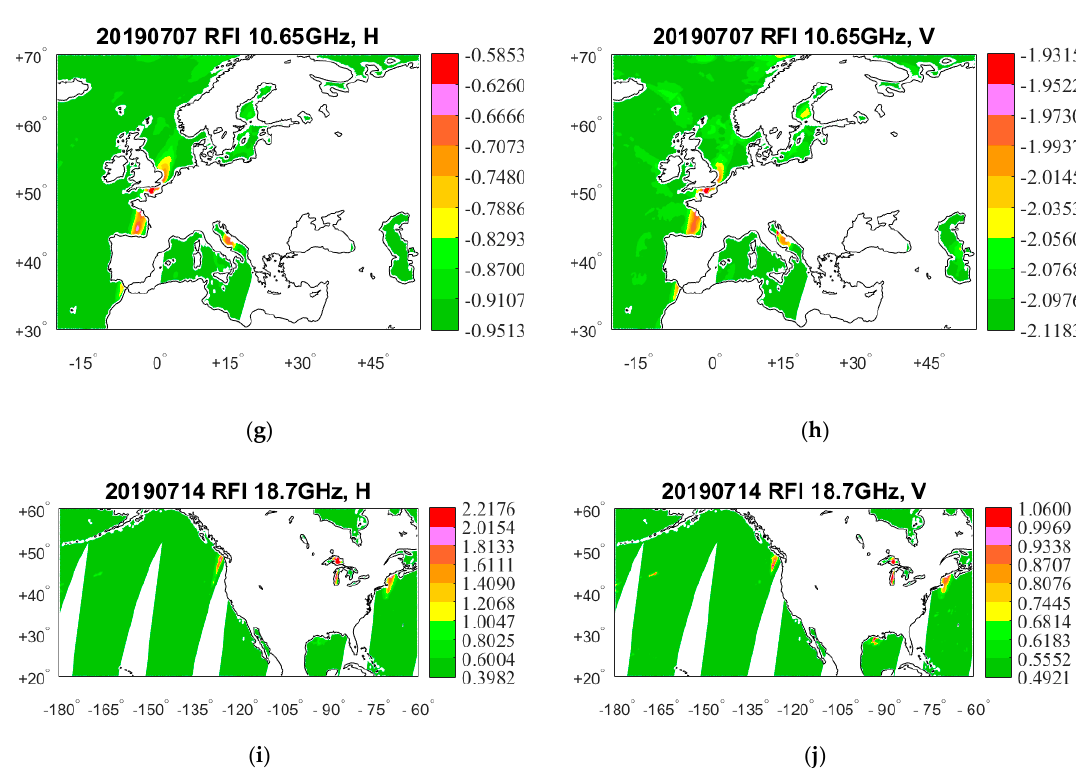
Figure 7. Spatial distribution of RFI for H-pol (left panels) and V-pol (right panels), using DPCA. ( a , b ) 12 July; ( c , d ) 11 July; ( e , f ) 12 July; ( g , h ) 7 July; ( i , j ) 14 July.